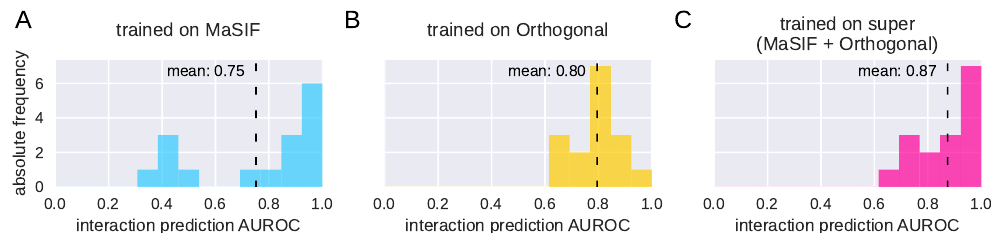
Figure 4. Histograms of AUROC of PPI prediction for the ternary complex dataset defined in Table 3, for models trained on different training sets. ( A ) Results for a model trained on the MaSIF dataset. ( B ) Results for a model trained on the Orthogonal dataset. ( C ) Results for a model trained on the super dataset, i.e., the union of the MaSIF and Orthogonal datasets. The increase of the mean AUROC indicates that the MaSIF dataset lacks diversity of protein structures; thus, it is not sufficient for the development of models in the context of targeted protein degradation. Adding the structures of the Orthogonal dataset leads to a strong improvement. See Tables A5–A7 in Appendix B for the underlying results on each ternary complex, and Tables A8 and A9 in Appendix B for exemplary confusion matrices using a threshold of 0.5.